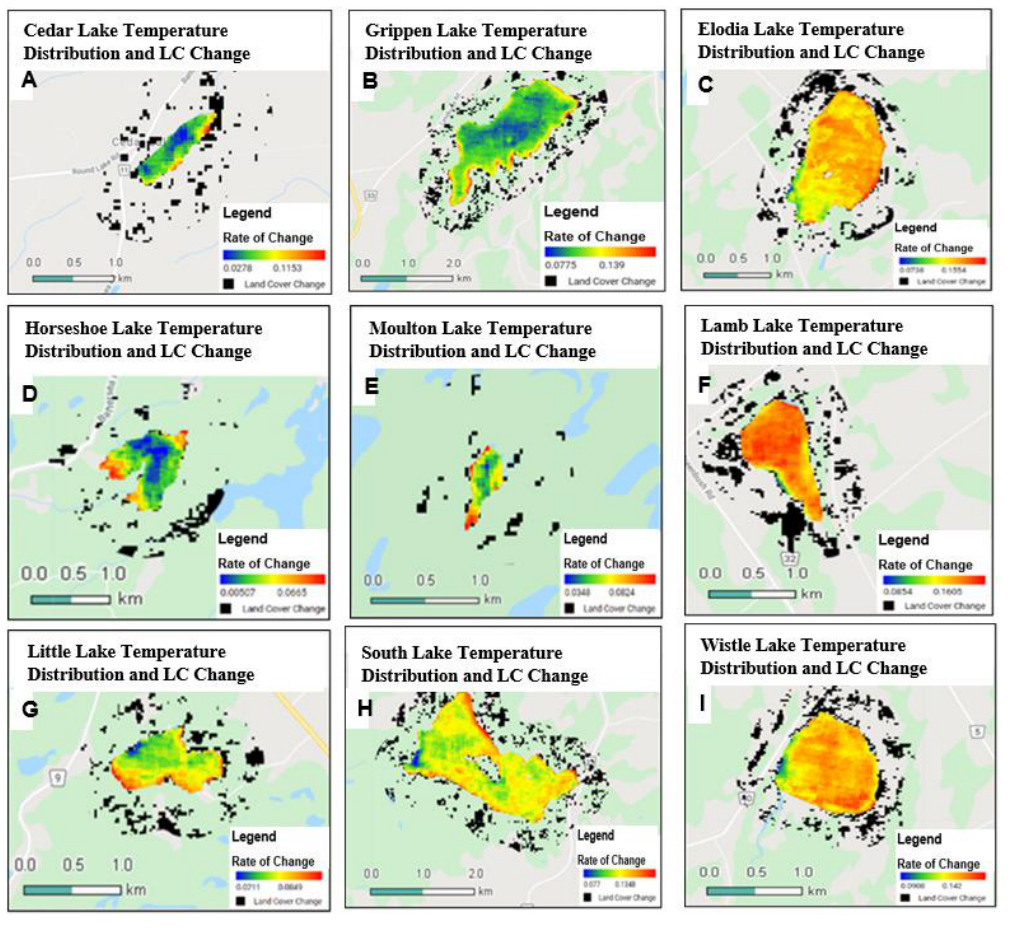
Figure 6. The land cover change (in dark) and rate of change of temperature trend distribution (in 10 − 4 °Kelvin per year) of nine lakes: ( A ) Cedar Lake; ( B ) Grippen Lake; ( C ) Elodia Lake; ( D ) Horseshoe Lake; ( E ) Moutlon Lake; ( F ) Lamb Lake; ( G ) Little Lake; ( H ) South Lake; ( I ) Wistle Lake.